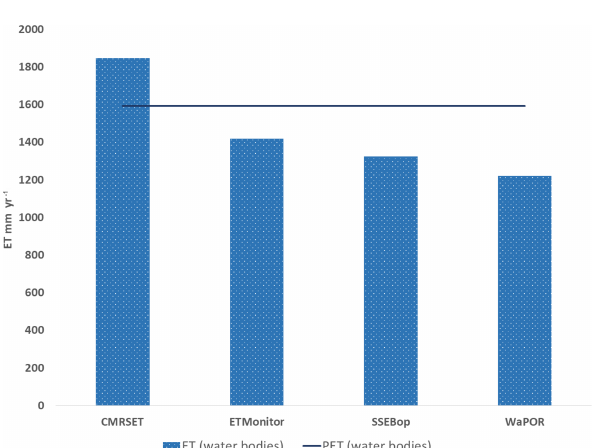
Figure 11. Comparison of mean ET across the selected forested area for each product versus the mean ET found from the literature.